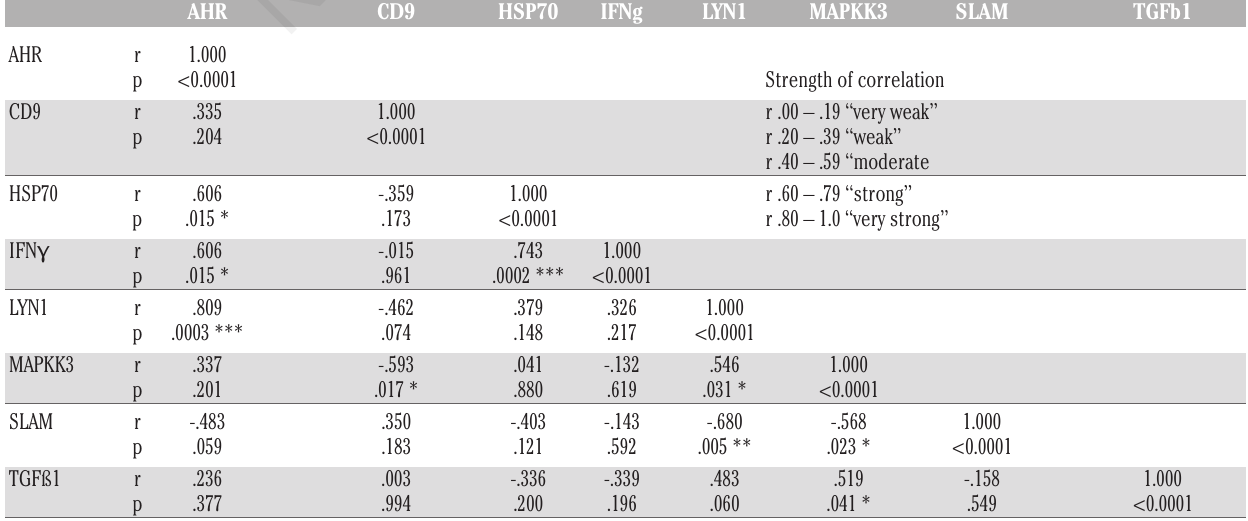
Table 3. Spearman correlation coefficient hemi-matrix for inter-relationships of genes of interest. Significant correlations (p < 0.05 *, p < 0.01 **, p < 0.001 ***, p < 0.0001 ****) are in bold.